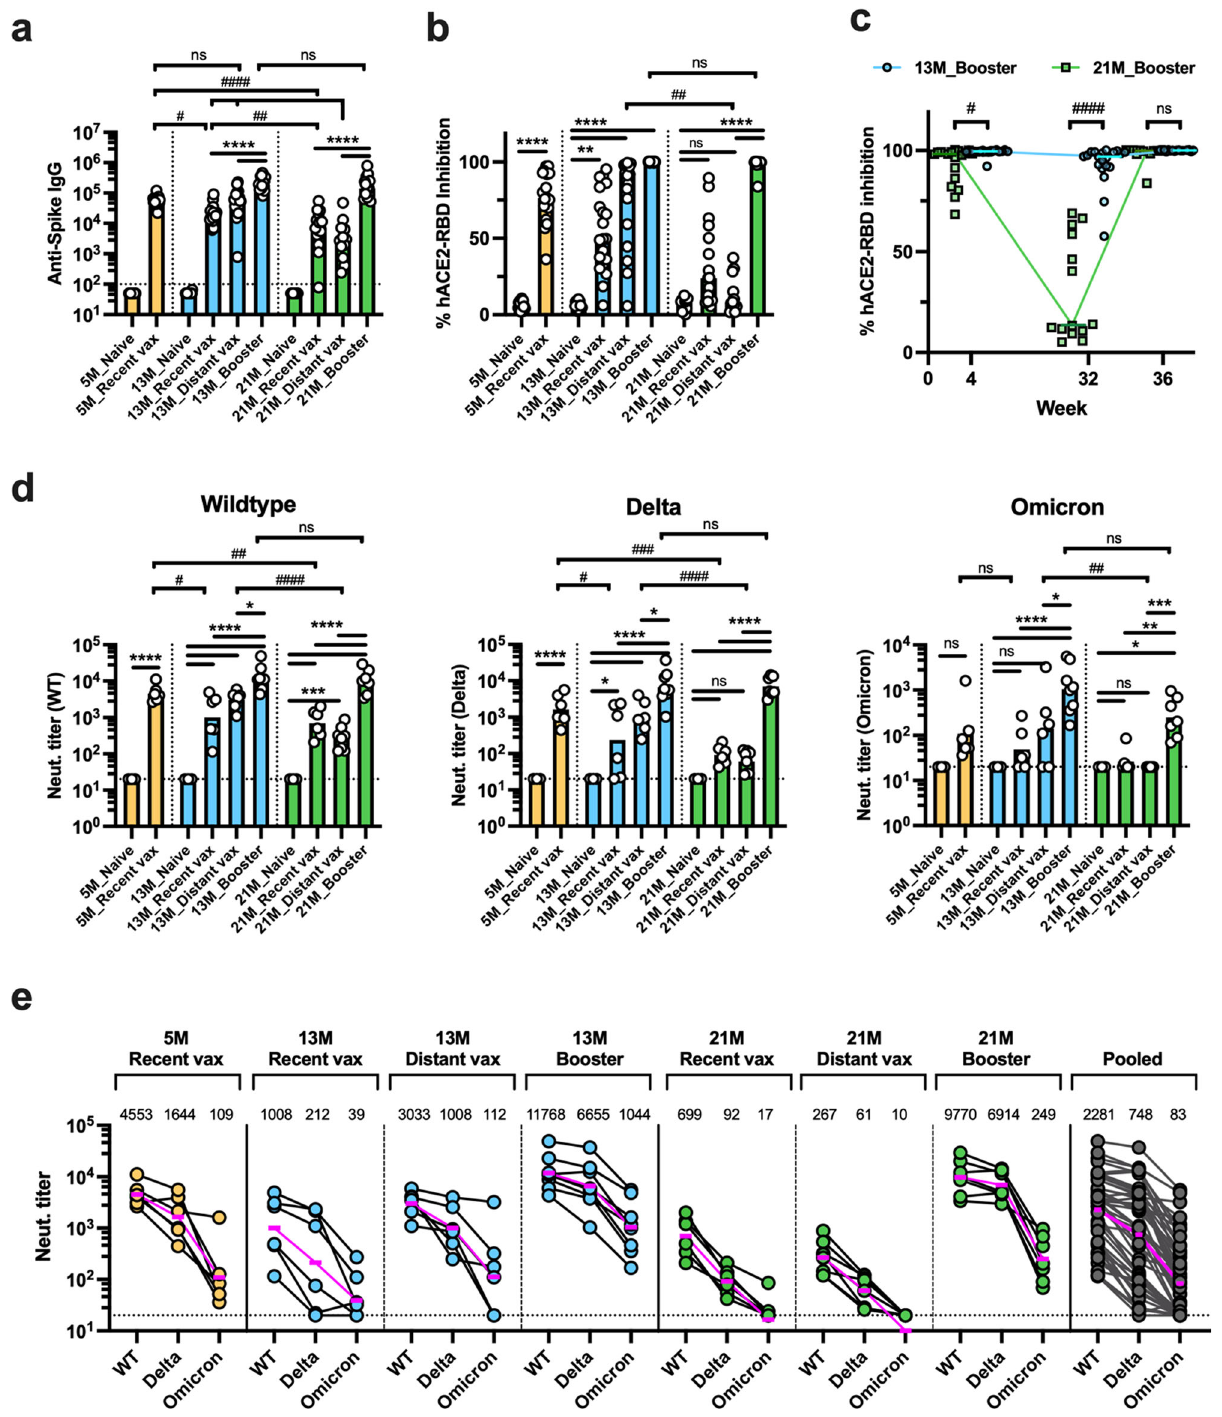
Fig. 2 A booster dose of mRNA BNT162b2 restores waning humoral responses in aged mice and elicits potent neutralizing activity against SARS-CoV- 2 Omicron. Sera were collected from immunized mice at week 36 to determine humoral responses as indicated in Fig. 1. Anti-WT spike IgG titers ( a ), hACE2-RBD (WT) inhibition rate ( b , c ), and neutralization titers against WT, Delta, and Omicron pseudoviruses ( d , e ) were determined. Results are presented as individual values with mean ( a , d ) or median ( b , c ). Dashed lines represent lower limit of detection. Data were analyzed by one-way ANOVA after log-transformation ( a , d ) or Kruskal – Wallis test ( b , c ) corrected for multiple comparisons. * indicates comparisons within the same age group and # indicates comparisons between different age groups. ( a – c ) N = 19 – 20 per group for 5 and 13 M aged mice, and N = 13 – 17 per group for 21 M aged mice. e Horizontal lines and numbers indicate geometric mean titers (GMTs). For GMT calculation, an arbitrary value of 10 was assigned to samples with values below the detection limit of 20. Dashed lines represent lower limit of detection. d , e N = 6 – 8 per group except for Naive mice ( N = 3).* /# P < 0.05, ** /## P < 0.01, *** /### P < 0.001, **** /#### P <